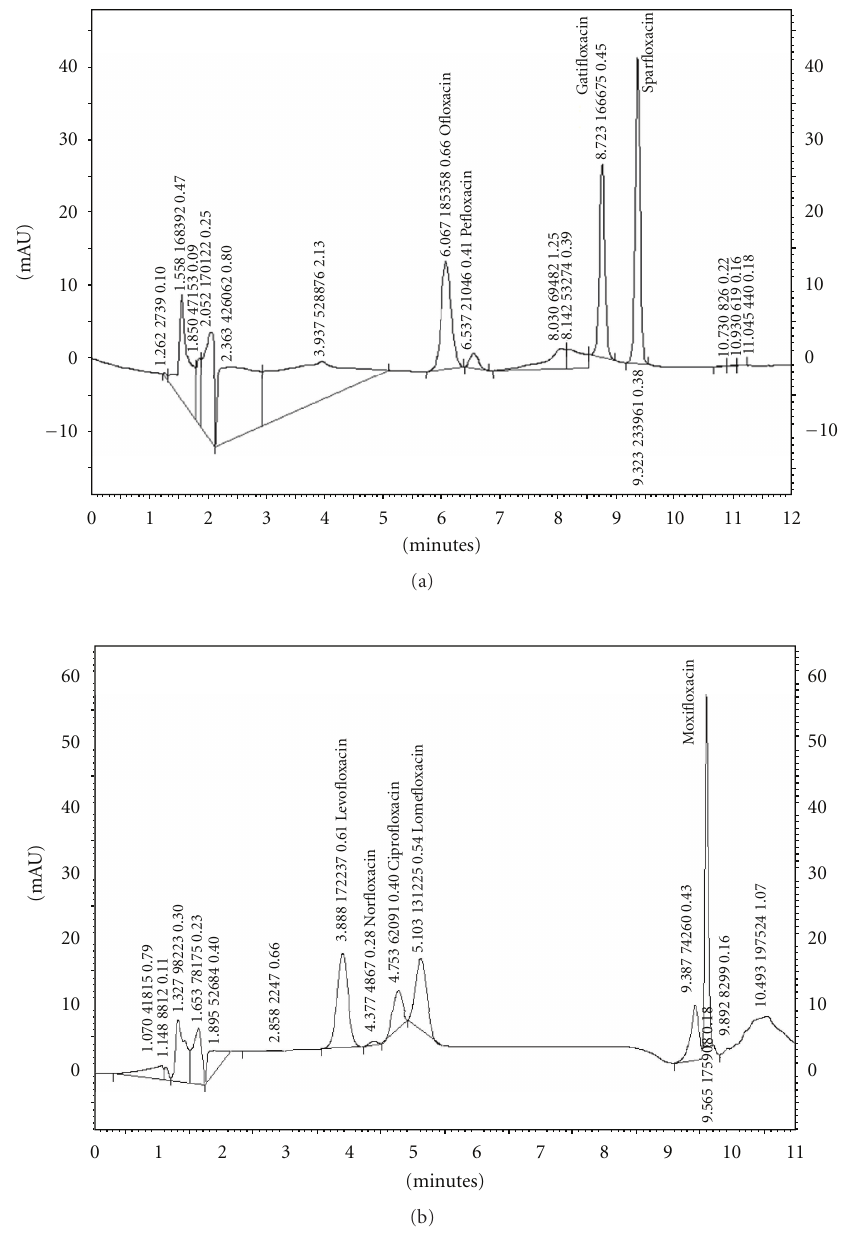
Figure 1: (a) Chromatogram of the fluoroquinolones in group A (ofloxacin, pefloxacin, gatifloxacin, and sparfloxacin) eluted in single run. (b) Chromatogram of fluoroquinolones in group B (levofloxacin, norfloxacin, ciprofloxacin, lomefloxacin, and moxifloxacin) eluted in single